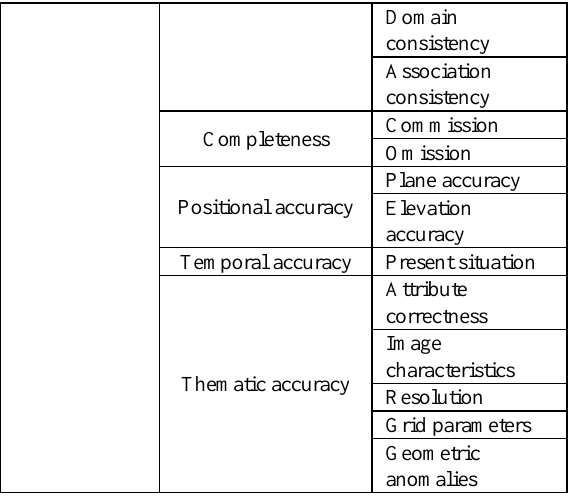
Table 1. List of quality elements, quality sub-elements and test items for data set quality